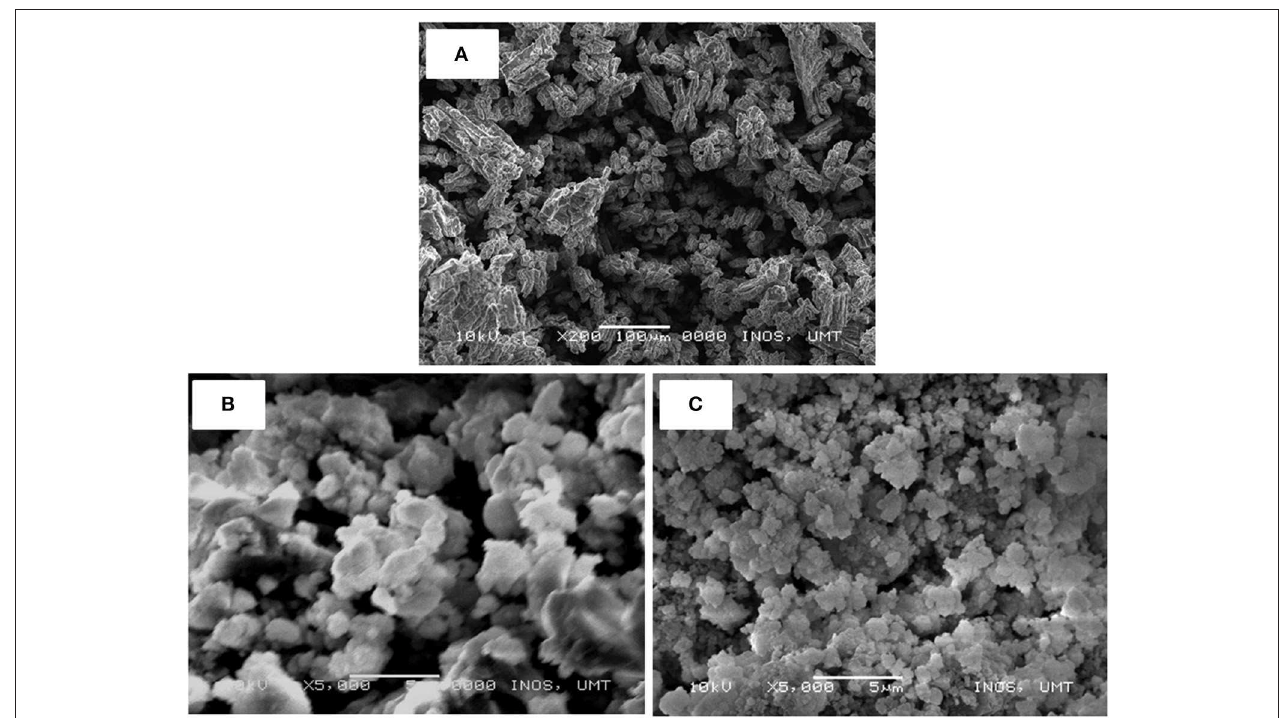
FIGURE 6 | SEM images of LiAlH 4 when (A) as-received, (B) as-milled, and (C) with 10 wt.% of K 2 NbF 7 .